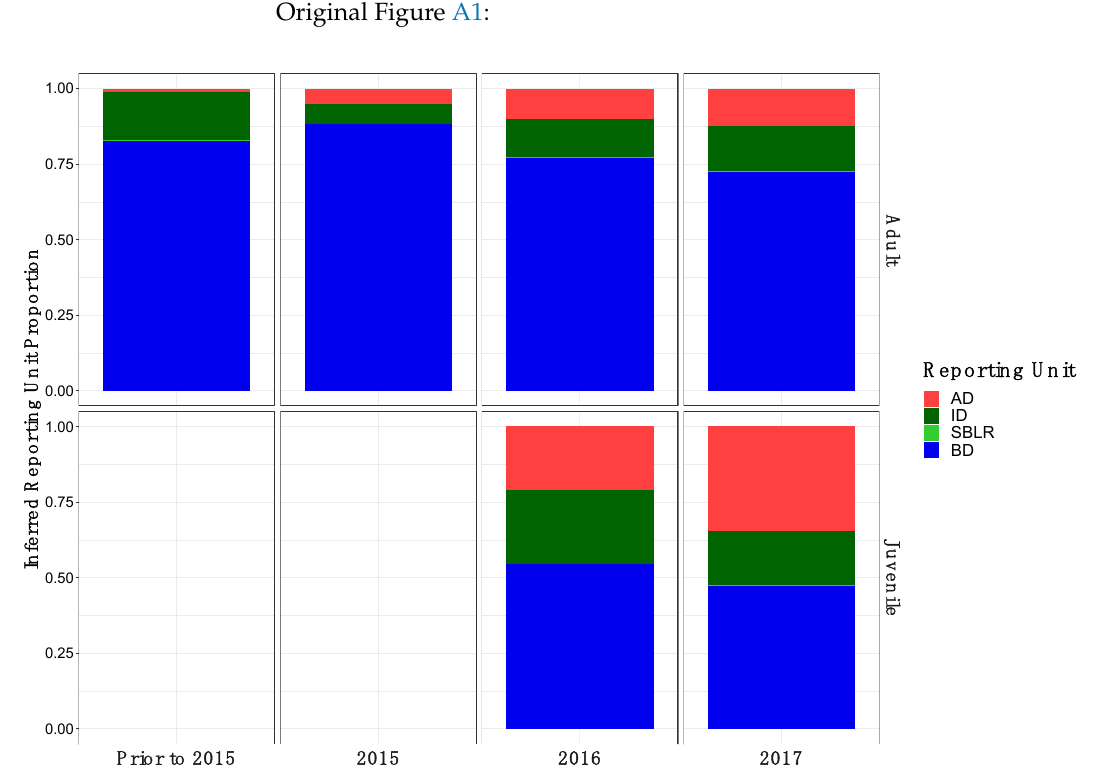
Figure A1. Inferred proportion of genetic ancestry from each of the four inferred populations across recolonizing adult and juvenile steelhead smolt life history cohorts from the GSI analysis (ii). Colors are representative of the inferred population. The bottom x axis divides life history cohorts temporally and the right y axis divides them by life history stage. Relative proportions of genetic ancestry from ID populations were greater in adult life history cohorts in GSI analysis (ii) compared to GSI analysis (i) and GSI analysis (iii).